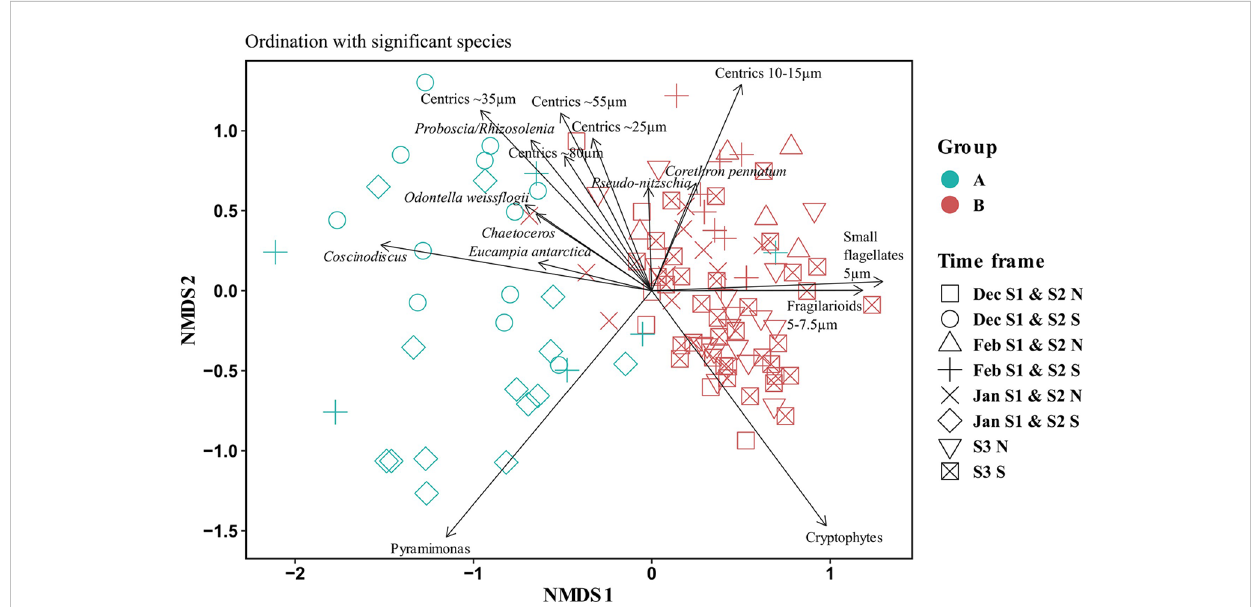
FIGURE 5 Non-metric multidimensional scale analysis (NMDS) based on the Bray-Curtis dissimilarities of the phytoplankton community composition (each taxa represented by their relative contribution to total biomass). The samples are colored according to group (A, light-blue or B, red) and labeled by time frame: Month (if applicable, Dec, Jan, Feb), Season (S1, S2, S3), and area (N, North or S, South). The black arrows show the main taxa that were signi fi cant in the statistical analysis. ANOSIM R = 0.7, p <0.001.